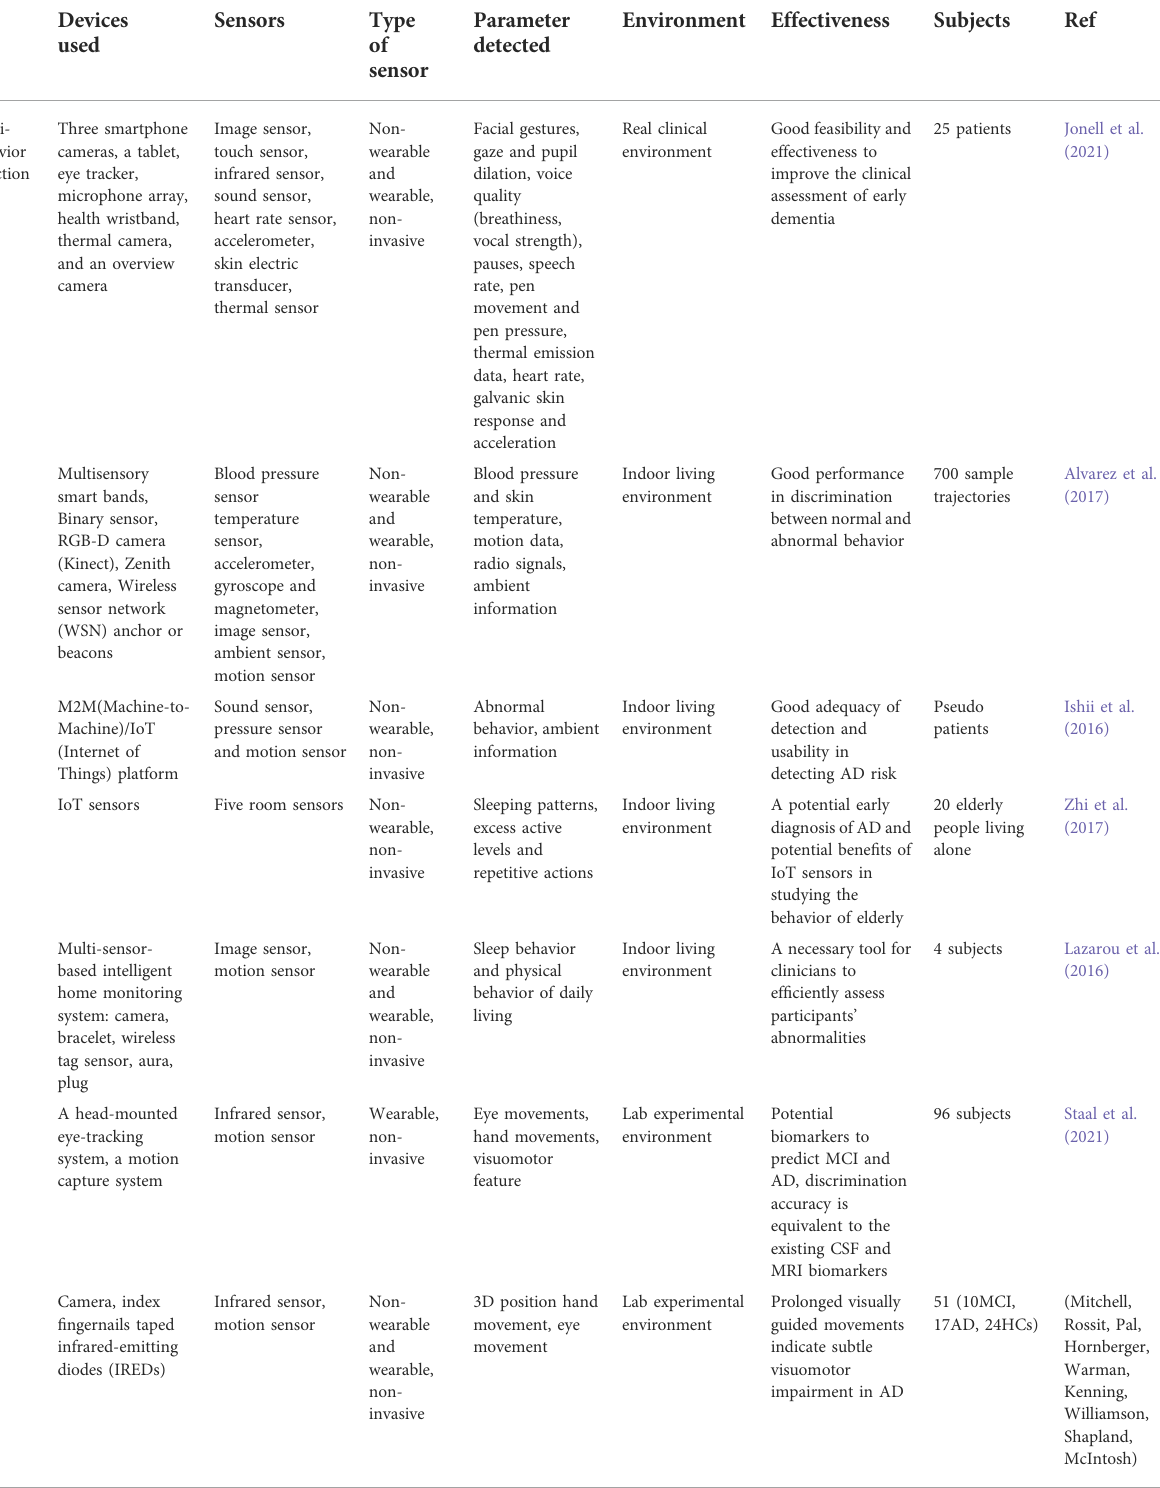
TABLE 4 List of sensor-based multi-behavior detection toward AD